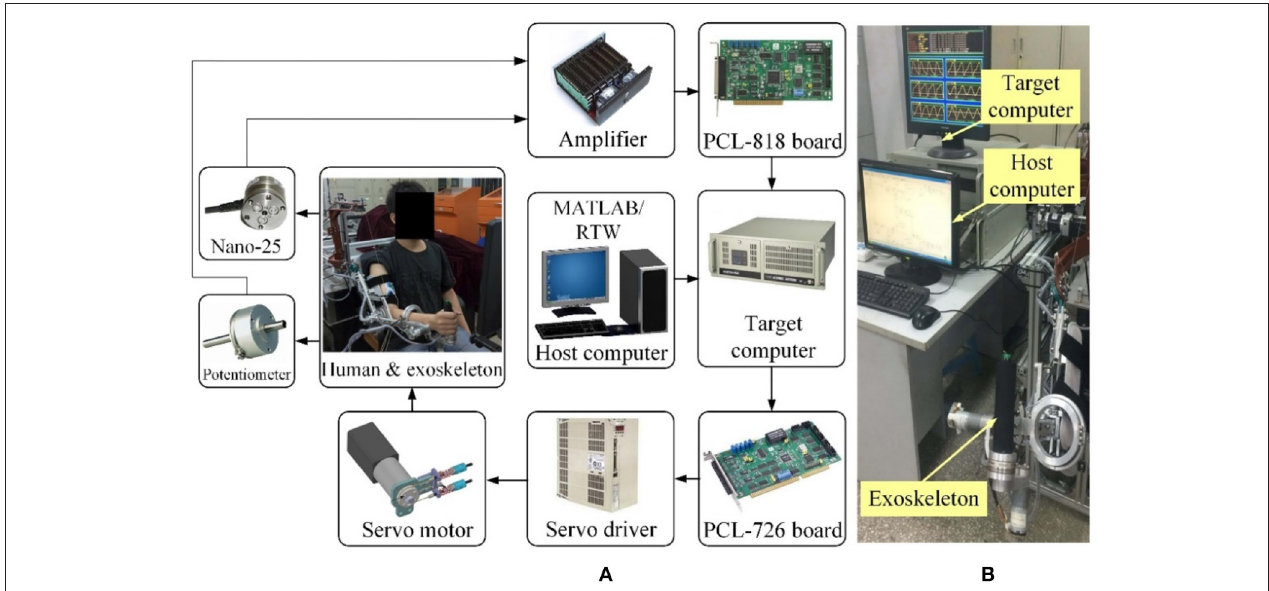
FIGURE 3 | The MATLAB/Real-Time-Workshop/xPC control system. (A) Hardware architecture diagram. (B) Experimental